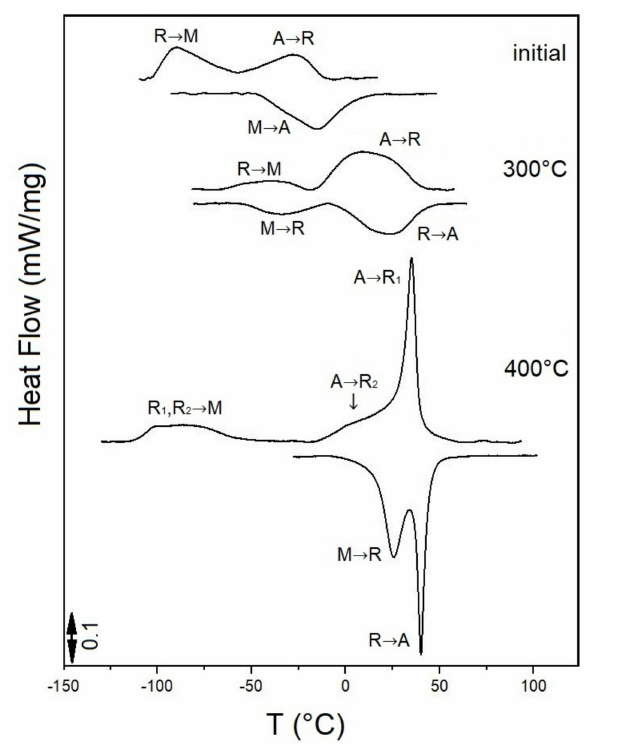
Figure 5. Calorimetric curves for cooling (upper traces) and heating (lower traces) of Ti-50.9Ni in initial state and annealed at 300 ◦ C and 400 ◦ C for 1